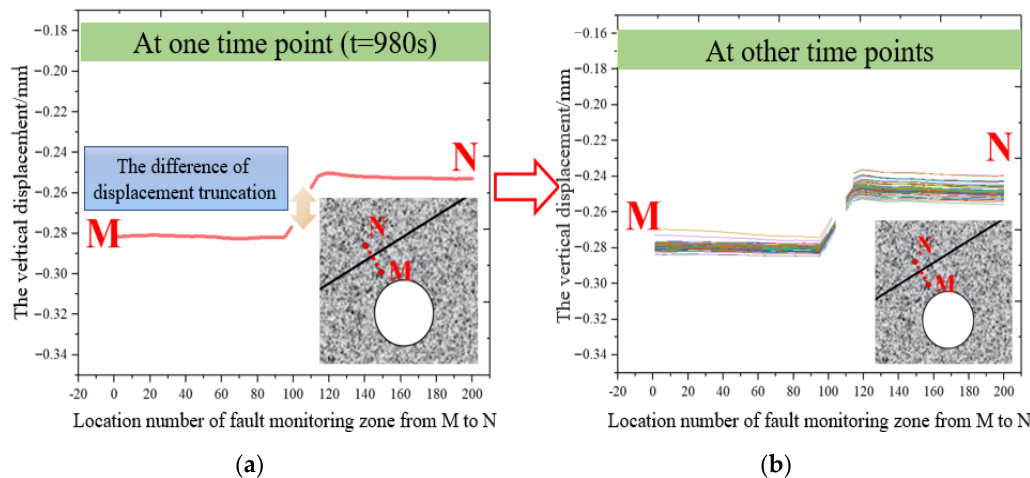
Figure 14. The vertical displacement drops of granite sample A-0 during 950 s~1088 s. ( a ) The vertical displacement drops when t=980 s; ( b ) The vertical displacement drops when other time points. Second, calculate the displacement drops for every time point. Each displacement line is shown in Figures 13b and 14b. The scatter diagram of the drop values versus time range in 950 s~1088 s was plotted (as shown in Figure 15a,b). Figure 15a shows that the discontinuity of horizontal displacement slowly rises with time. In Figure 15b, an obvi ‐ ous linear relationship was not shown, but the displacement drops were maintained at 0.022–0.025 mm before the sample reached failure. To ensure accuracy, the mean value of the scattered points within this range was taken as the vertical displacement discontinu ‐ ity value for sample A ‐ 0, as shown in Figure 15b.